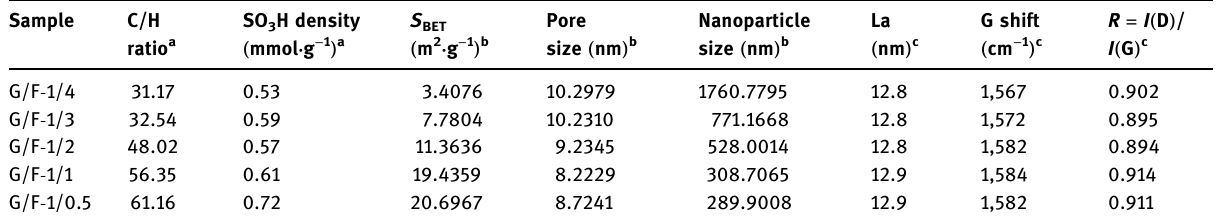
Table 1: Structural parameters of carbon solid acid catalysts